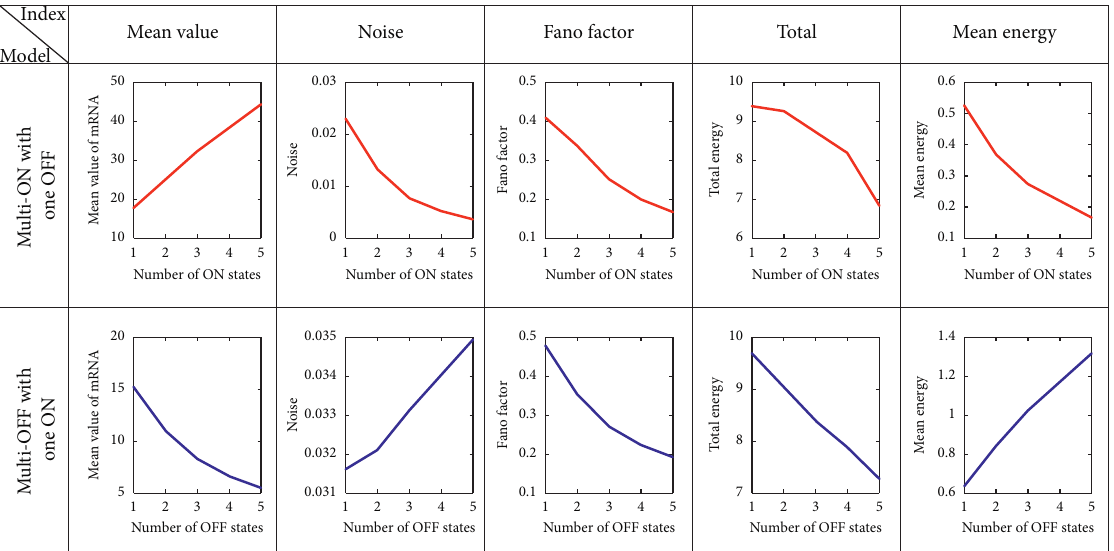
Figure 5: Effect of promoter’s multiple states on energy consumption and gene expression (mean, noise, and Fano factor). In all the cases, the rates of activator or inhibitor association and dissociation are set as 0.27 and 0.23; that is, the switch rates of the promoter states are set as � 0 . 27 , λ � 0 . 23 , λ � 0 . 27 , λ � 0 . 23 , λ � 0 . 27 , λ � 0 . 23 , ... , λ � 0 . 27, and λ � 0 . 23, the transcription rates are set as μ � 33 λ n 0 01 10 12 21 23 32 0 n